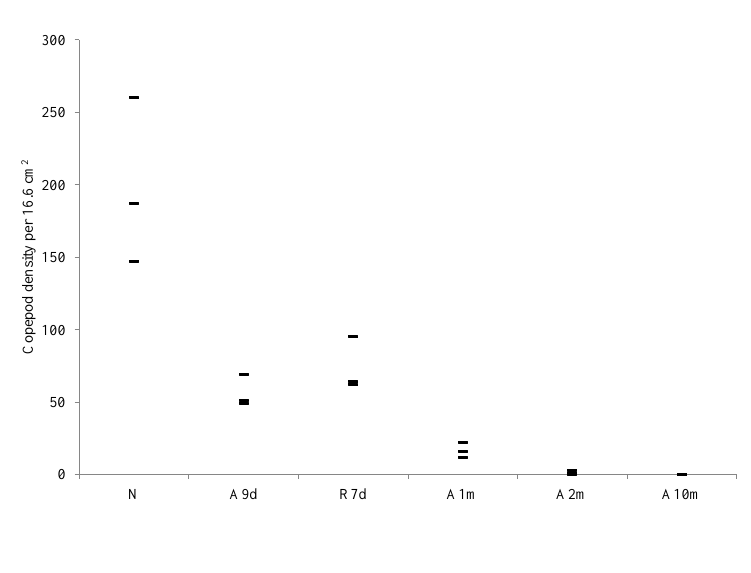
Fig. 1. Absolute copepod densities (ind. per 16.6cm − 2 ) in all samples (pooled depths, copepodites included).